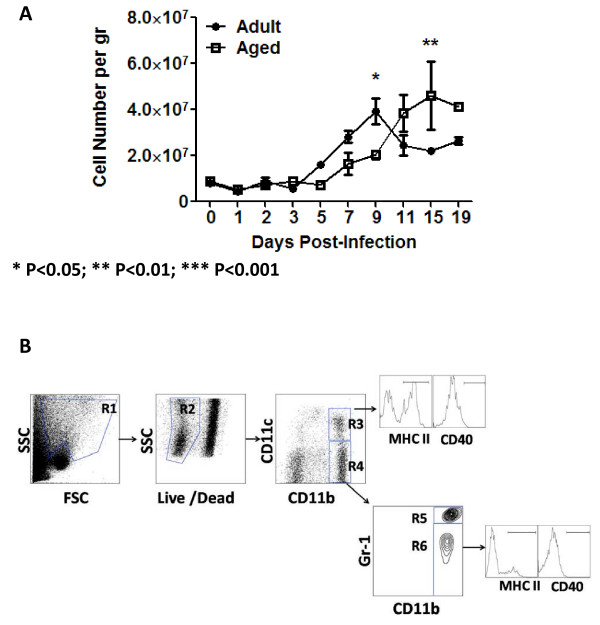
Lung Cell Infiltration. Isolated lung cells were evaluated for viability by trypan blue exclusion (A). The number of cells was adjusted for the weight of the lungs and reported as cells per gram of tissue. Aged mice (white squares) showed a delay in the kinetics of lung cell. The graph shows cumulative data of three sets of experiments, a total of 9 mice were assayed at each time point, except for days 15 and 19, which contain 8 animals each. (B) Gating strategy used to analyze innate cells in the lungs. Initially cells were gated in the non-lymphocyte area (R1), this was followed by selection in the live gate (R2). Two APC populations (R3 and R4 gates) were selected based on CD11b and CD11c expression. R3 gate corresponds to cDCs (CD11chigh/CD11bhigh). Cells in R4 gate were further divided based on the diffential expression of Gr-1 (neutrophils (CD11bhigh/CD11clow/Gr1high) and lung macrophages (CD11bhigh/CD11clow/Gr1med). MHC class II and CD40 expression was analyzed in R3 and R6 gates. An average of 500,000 events was collected for the analysis of these populations. Stars indicate statistical difference between aged and naïve animals.*P < 0.05. **P < 0.01. ***P < 0.001.